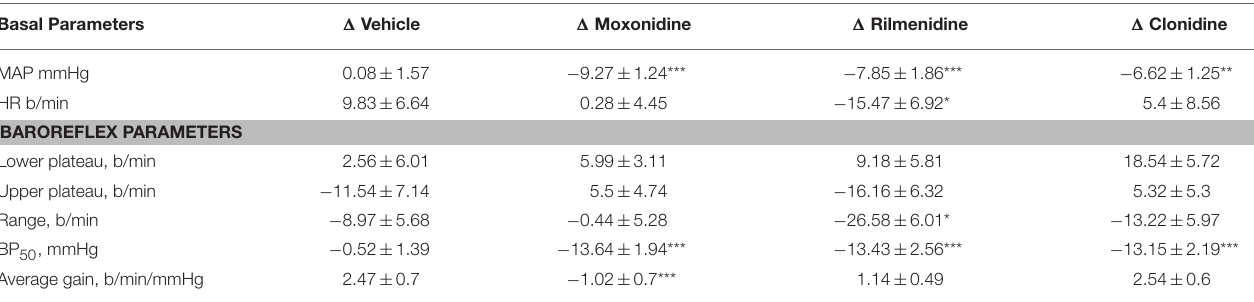
TABLE 5 | Comparison of chronic effect of moxonidine, rilmenidine and clonidine on intact (vagal and sympathetic) baroreflex curve parameters compared to vehicle. Basal